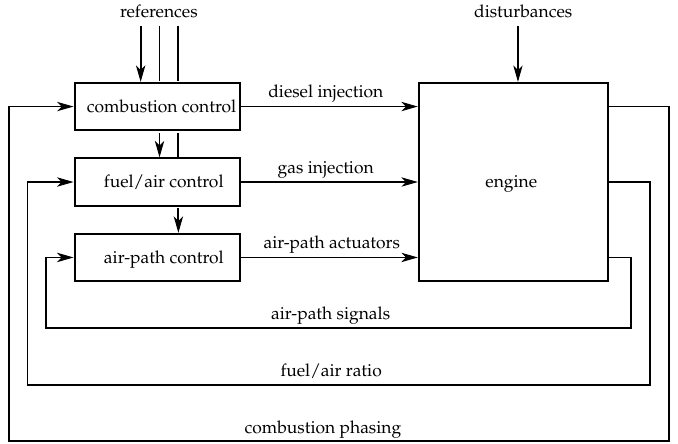
Figure 1. Overall control structure: the combustion controller, the air-path controller and the fuel/air ratio controller serve as the three main controllers.